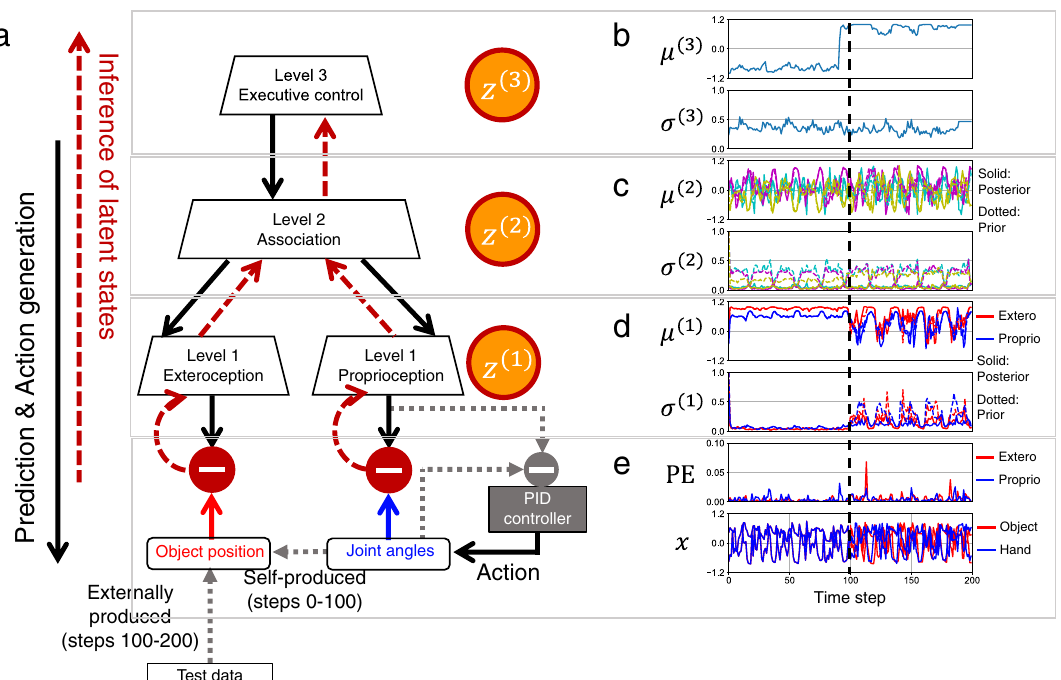
Figure 2. Test setting and an example of the result. ( a ) Online inference of latent states and action generation by a PID controller, with synaptic weights fixed. ( b ) Executive-level posterior distribution. ( c ) Association- level posterior and prior distributions. ( d ) Sensory-level posterior and prior distributions in exteroceptive and proprioceptive areas. ( e ) Prediction error (PE) and real sensations for exteroception and proprioception. For clarity, proprioception is represented as the 2-dimensional hand position, although the actual proprioception comprises 3-dimensional joint